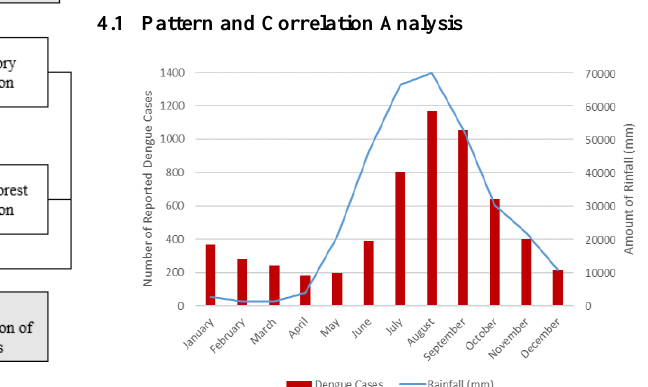
Figure 1. General workflow of methodology